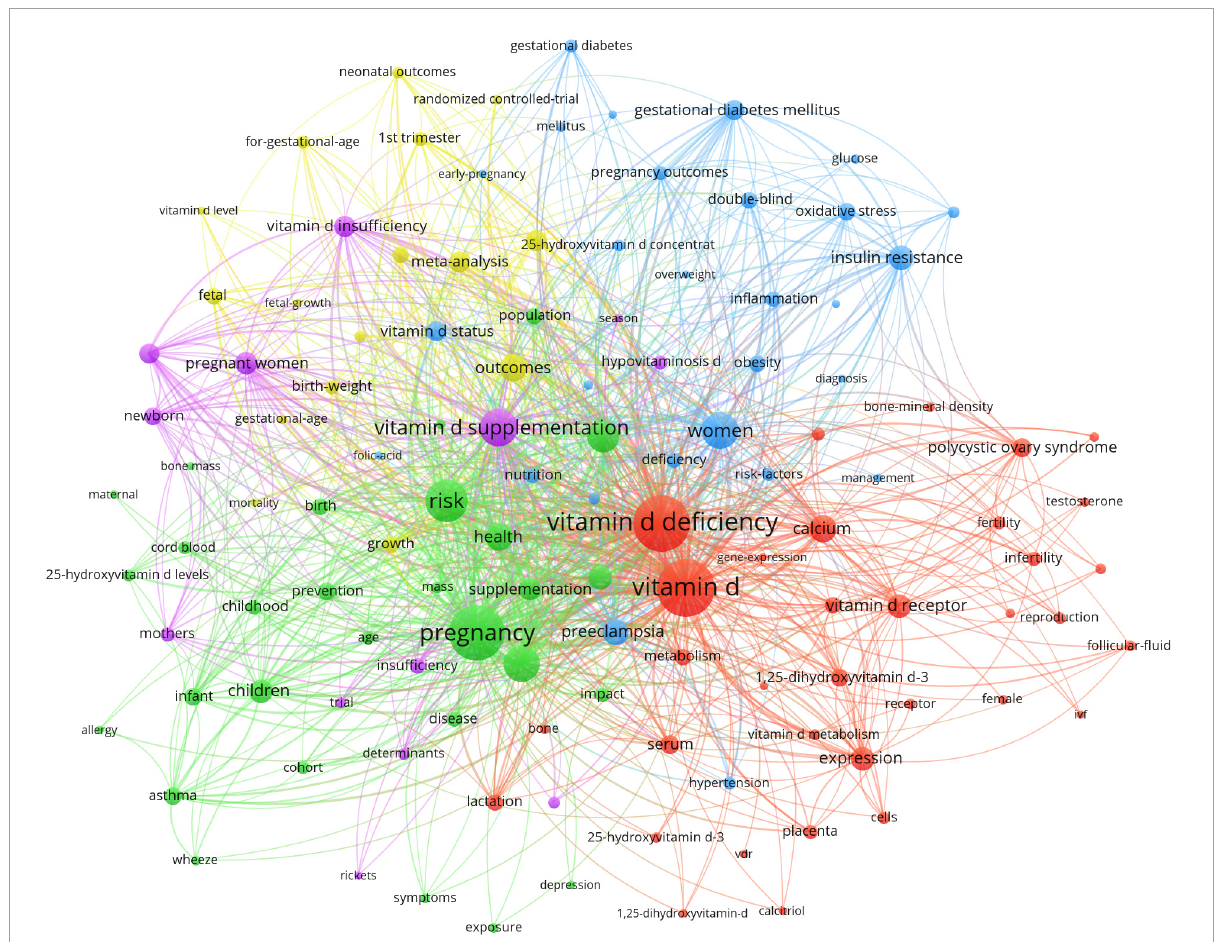
FIGURE5 Network visualization of keywords in studies on vitamin D and reproductive health.